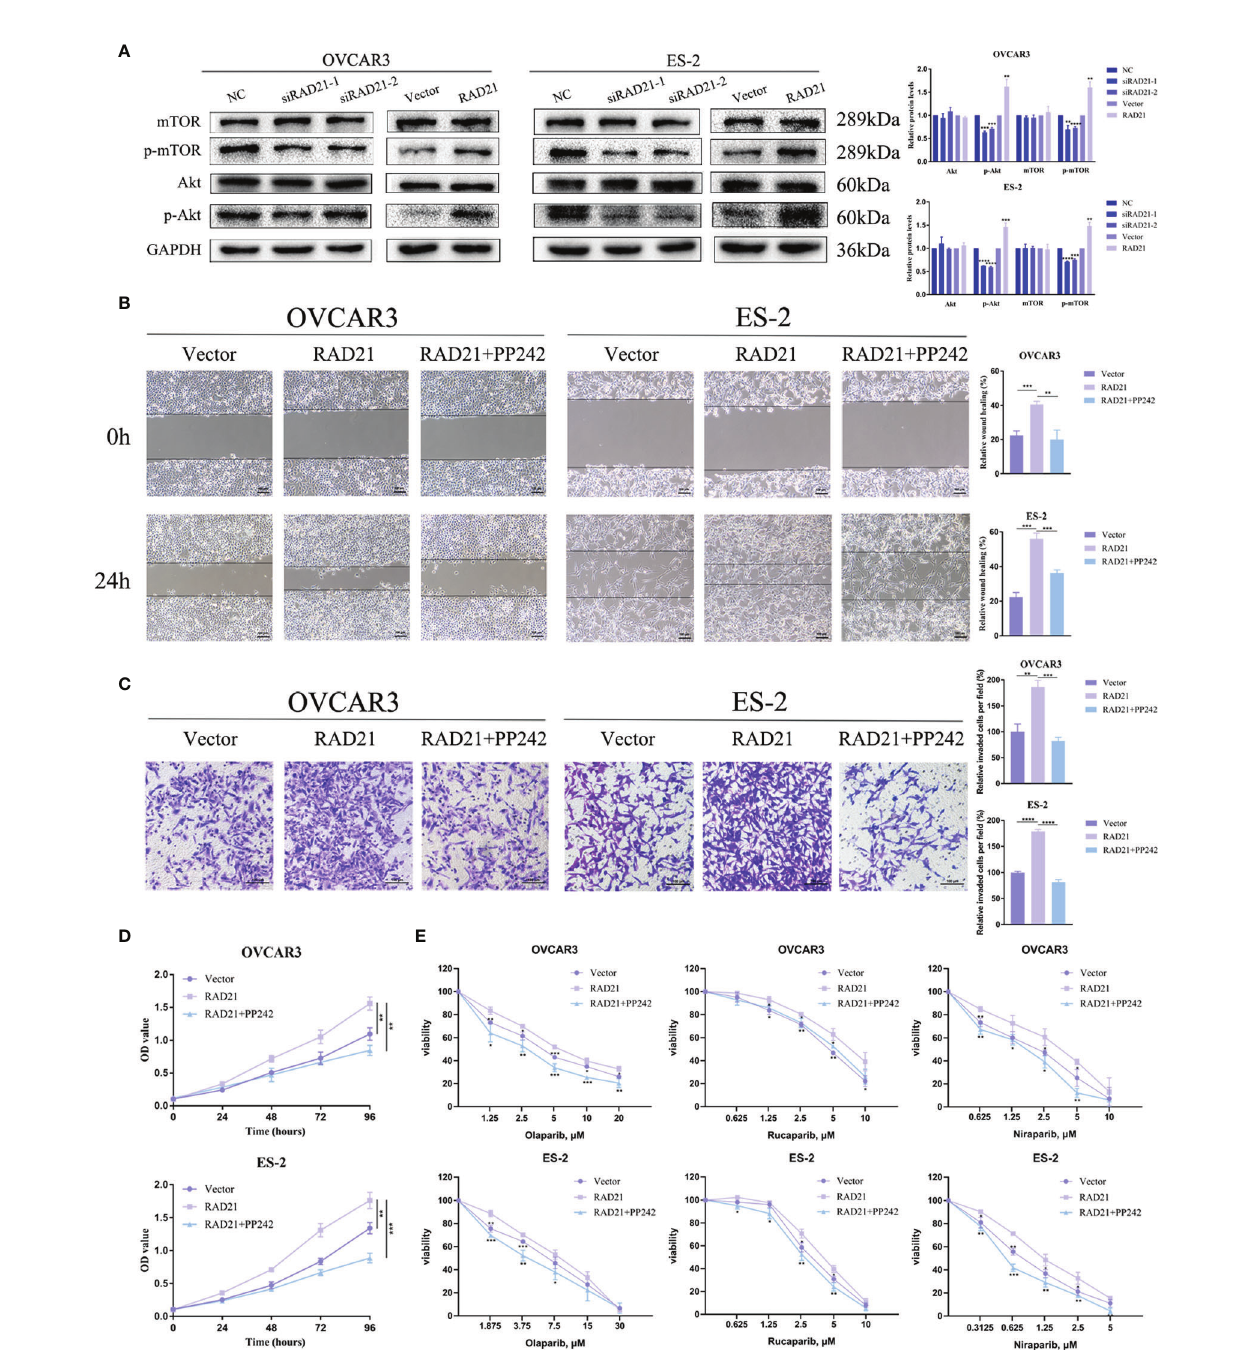
FIGURE 5 | RAD21 regulated ovarian cancer progression by activating the Akt/mTOR signaling pathway. (A) Western blotting analysis showing the levels of Akt, p- Akt, mTOR, and p-mTOR in ovarian cancer cells with RAD21 knockdown or overexpression. (B) Wound-healing assay showing the migration ability of ovarian cancer cells treated with PP242. (C) Invasion assay showing the invasion ability of ovarian cancer cells treated with PP242. (D) Cell Counting Kit-8 (CCK8) assay showing the proliferation ability of ovarian cancer cells treated with PP242. (E) Cell viability of ovarian cancer cells treated with PP242 and poly(ADP-ribose) polymerase (PARP) inhibitors. Data were represented as mean ± SD (n = 3). * p < 0.05; ** p < 0.01; *** p < 0.001; **** p <